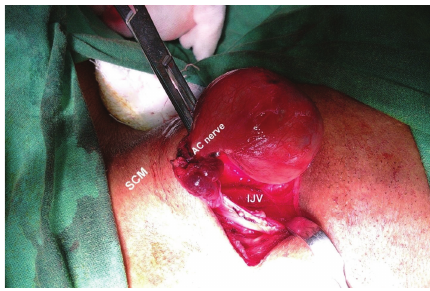
Figure 1: Tumor arising from inferior root of ansa cervicalis nerve. Figure 2: Cut section of the tumor showing solid and cystic areas.